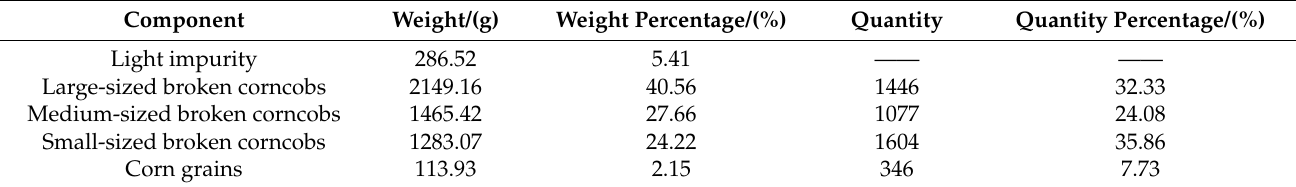
Table 1. Composition of effluent.